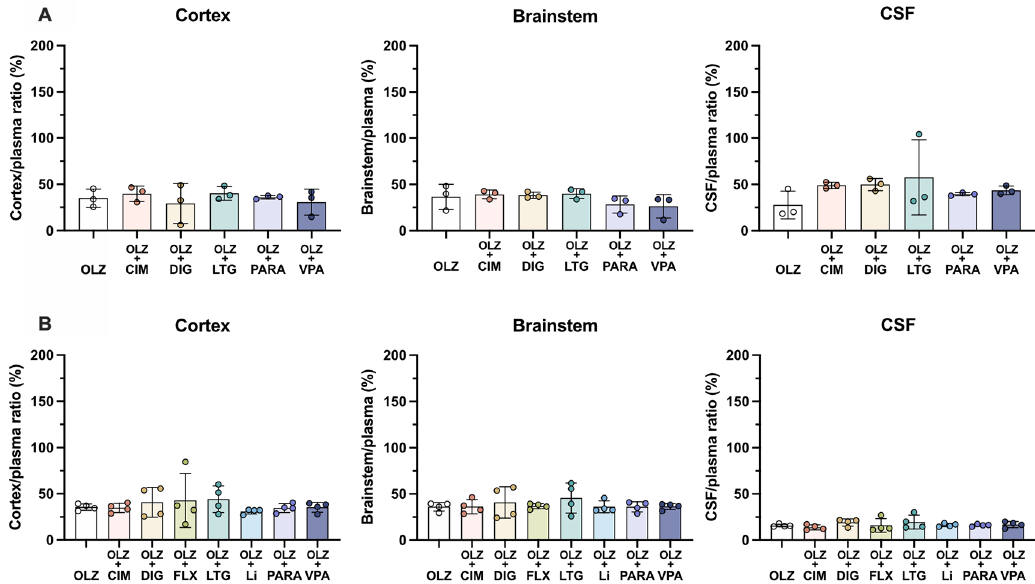
Figure 8. Entry of [ 3 H]-olanzapine into the (A) non-pregnant adult and (B) postnatal day 4 rat brain cortex, brainstem and cerebrospinal fluid (CSF). Single intraperitoneal ( i.p. ) injection either as monotherapy or in combination with: cimetidine (CIM, 11 mg/kg), digoxin (DIG, 0.03 mg/kg), lamotrigine (LTG, 6 mg/kg), paracetamol (PARA, 15 mg/kg) or valproate (VPA, 30 mg/kg). Bars are means (cid:3) SD. Note each point is an individual animal (n=3 – However, in fetal animals at E19 co-treatment with either digoxin (192 (cid:3) 31%, n=8) or lamotrigine (209 (cid:3) 49%, n=10) increased olanzapine transfer into the fetal brain cortex compared to olanzapine alone (128 (cid:3) 26%, n=21, both p<0.0001). This trend was also seen in the brainstem, where digoxin and lamotrigine combination therapy also increased olanzapine permeability compared to olanzapine monotherapy (from 129 (cid:3) 25%, n=21, to 187 (cid:3) 27%, n=8, or 232 (cid:3) 49%, n=10 respectively, both p<0.0001). In the CSF, combination therapy with paracetamol decreased olanzapine transfer from